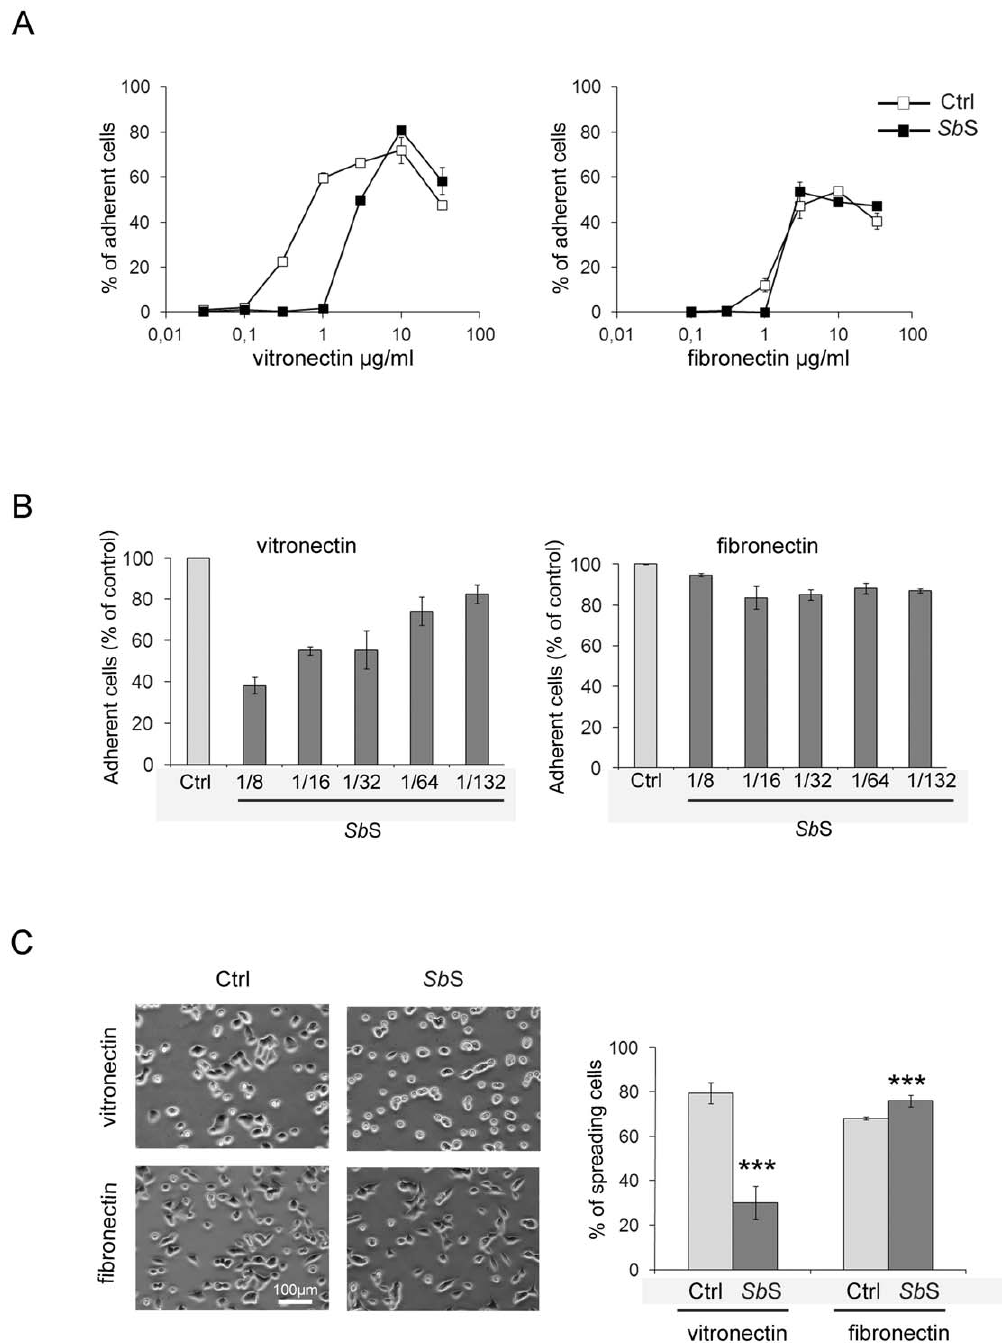
Figure 3. Sb S down-modulates cell adhesion to vitronectin. (A) Isolated HCT-8/E11 cells were treated with or without Sb S (dilution 1/8) and plated on either fibronectin or vitronectin at the indicated concentrations. Cell-ECM adhesion was evaluated as described in Methods. Results are expressed as the percentage of cell adhesion. Data represent the mean + SD of 3 separate experiments. (B) HCT-8/E11 cells were treated with or without dilutions of Sb S and plated on vitronectin (Vn). Cell-vitronectin adhesion was evaluated as described in Methods. (C) HCT-8/E11 cells were treated with or without Sb S, seeded in vitronectin-coated or fibronectin-coated wells and allowed to adhere for 2 h at 37 u C. Spreading cells were counted microscopically. Results are expressed as the percentage of spreading cells. Data represent the mean + SD of 3 separate experiments. *** P , 0.001.